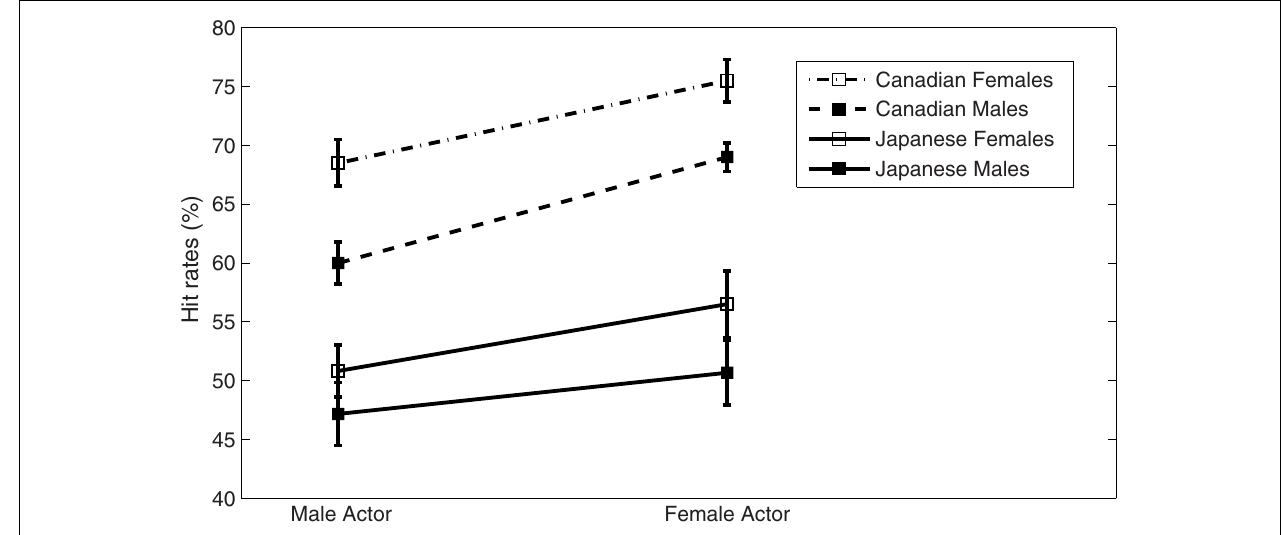
FIGURE 2 | Hit rates (percentage of test items with maximal rating on the scale corresponding to the portrayed emotion) split by actor’s and participant’s